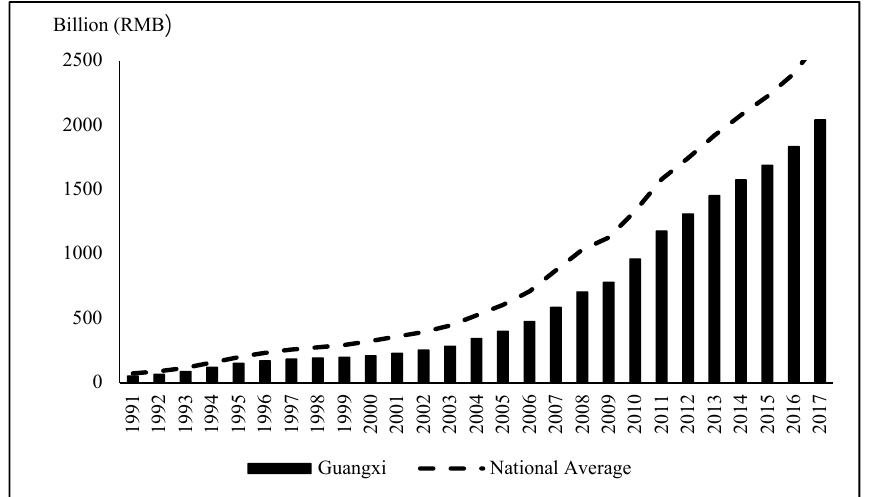
Figure A1. The development of GDP: Guangxi and the national average.